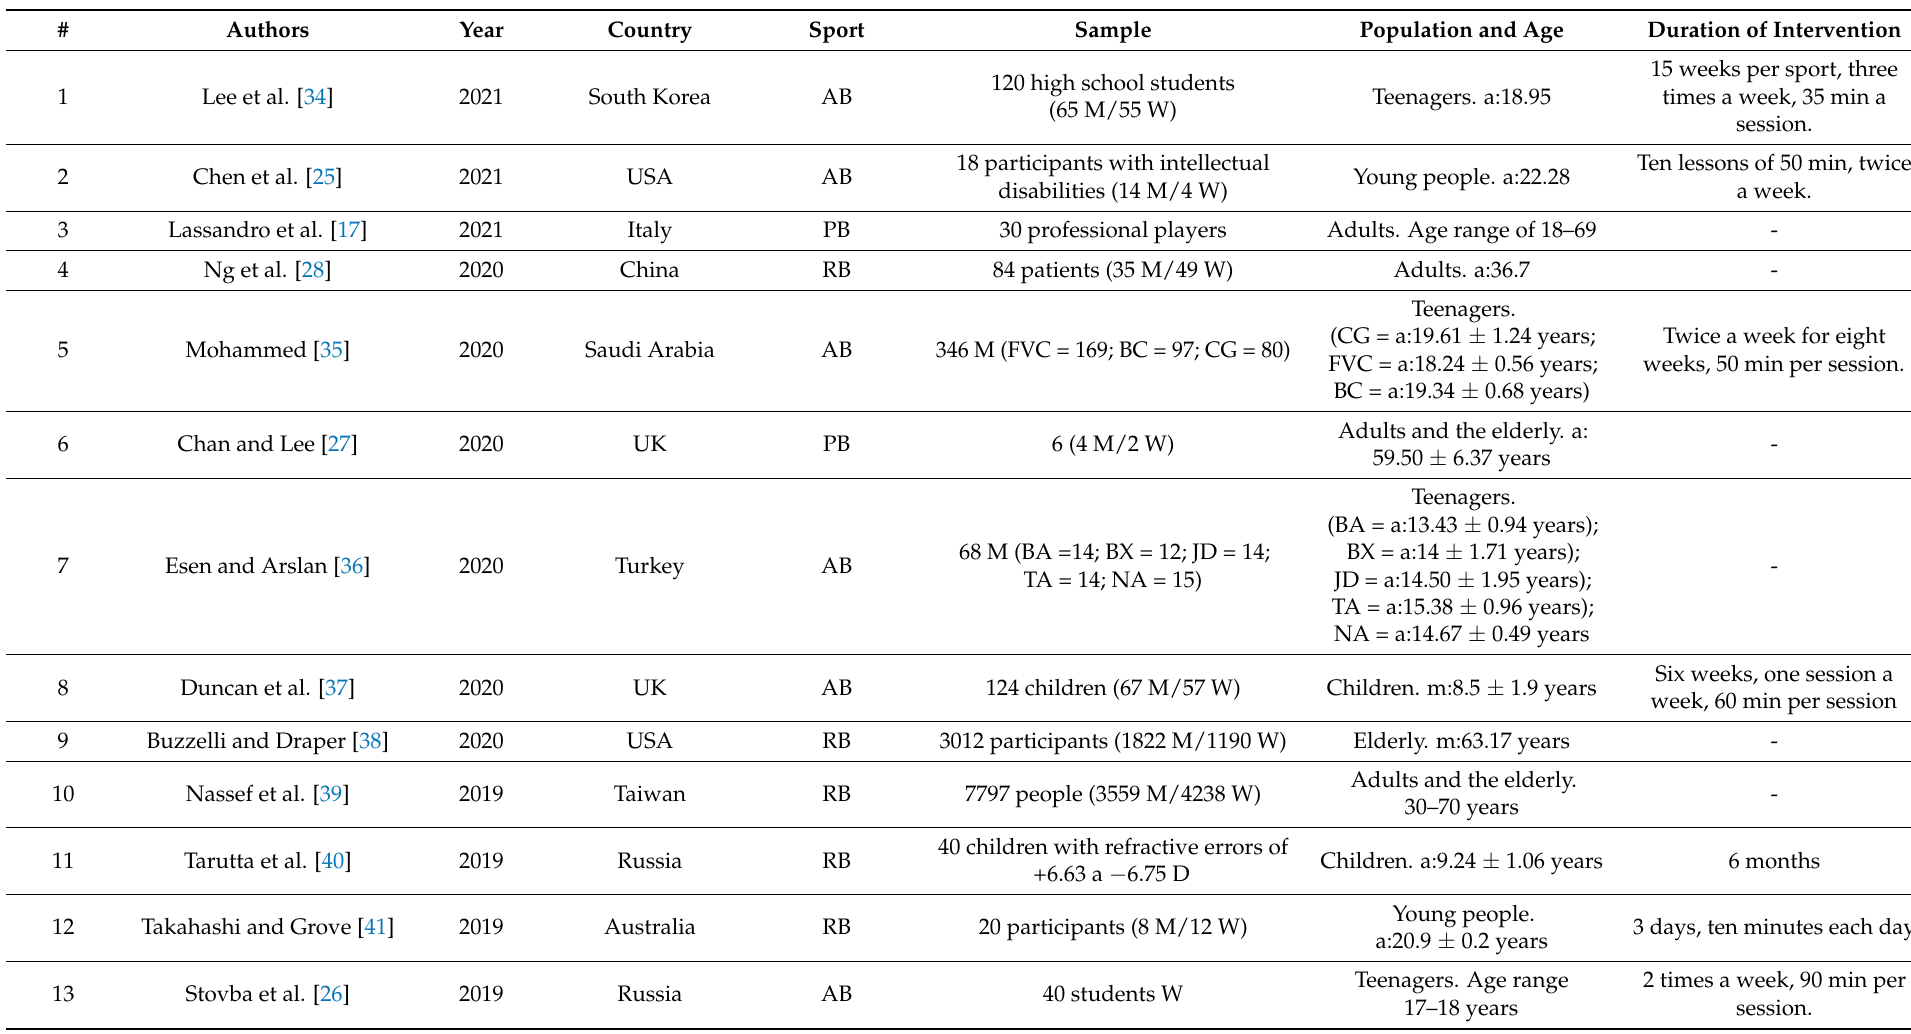
Table 1. Main data gathered from selected